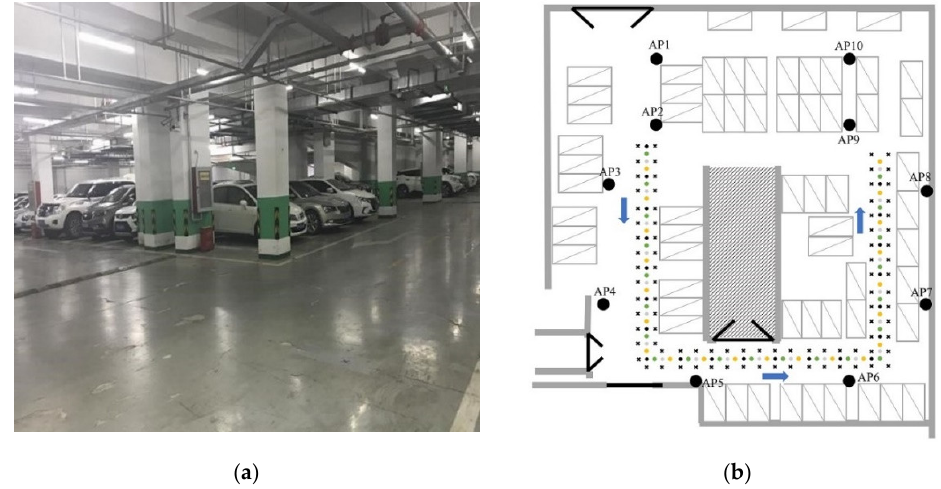
Figure 7. Experimental environment. ( a ) The actual scene of the underground parking lot. ( b ) Structural diagram of the experiment area.